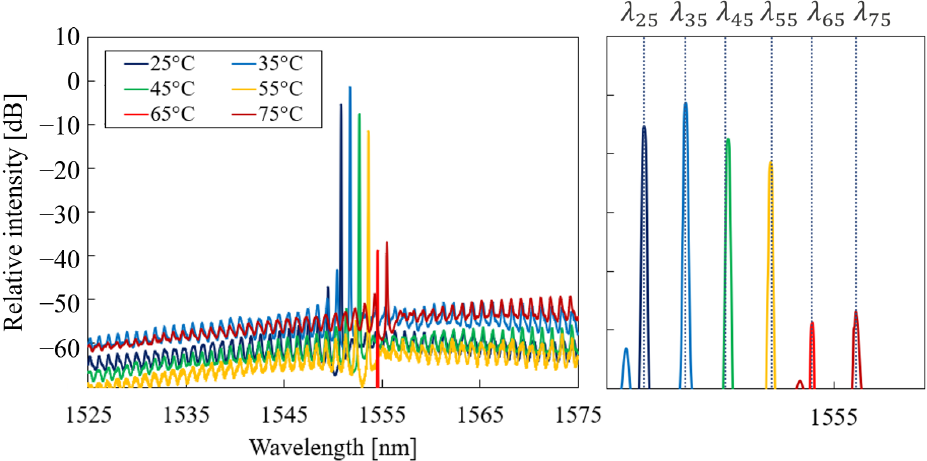
Figure 5. Measured laser spectrum for different temperatures. The detailed view shows the main extracted emission wavelength. The intensity of power spectral density was measured at a resolution of 20 pm.